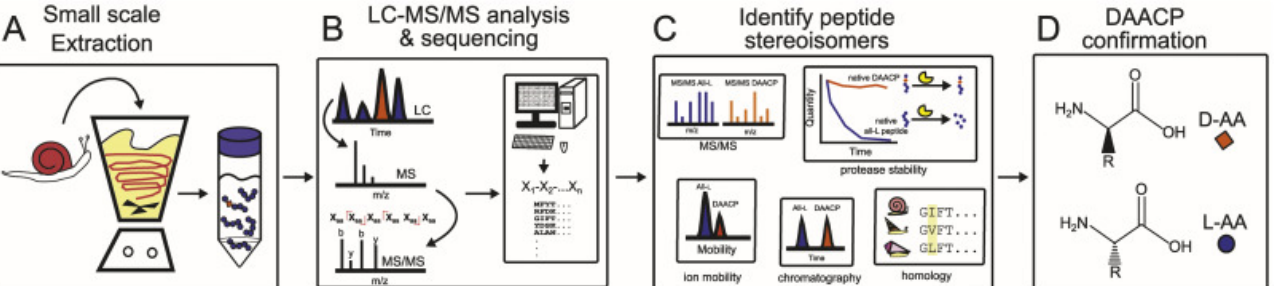
Figure 2. General workflow for D- aa containing peptides (DAACP). ( A ) extraction ( B ) LC-MS/MS analysis and sequencing by database search to identify native peptides. ( C ) Identification of putative isomeric peptides detected in LC-MS/MS analysis by analysing ion mobility migration, MS/MS, protease stability, chromatographic retention, or homology. ( D ) DAACP confirmation by comparison against the properties of native peptides and using synthetic standards. Reprinted with permission from Ref. [11]. Copyright 2020 Elsevier.